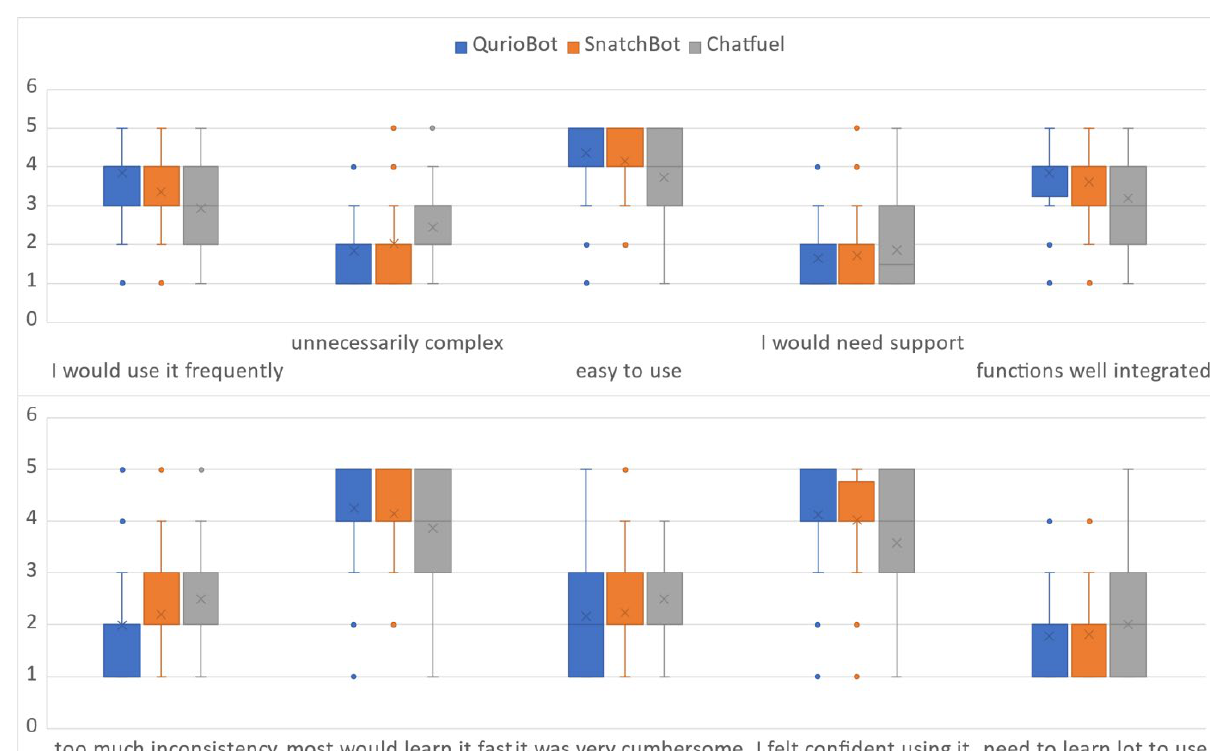
Figure 6. Box Plot of evaluation results from the chatbot user experience.